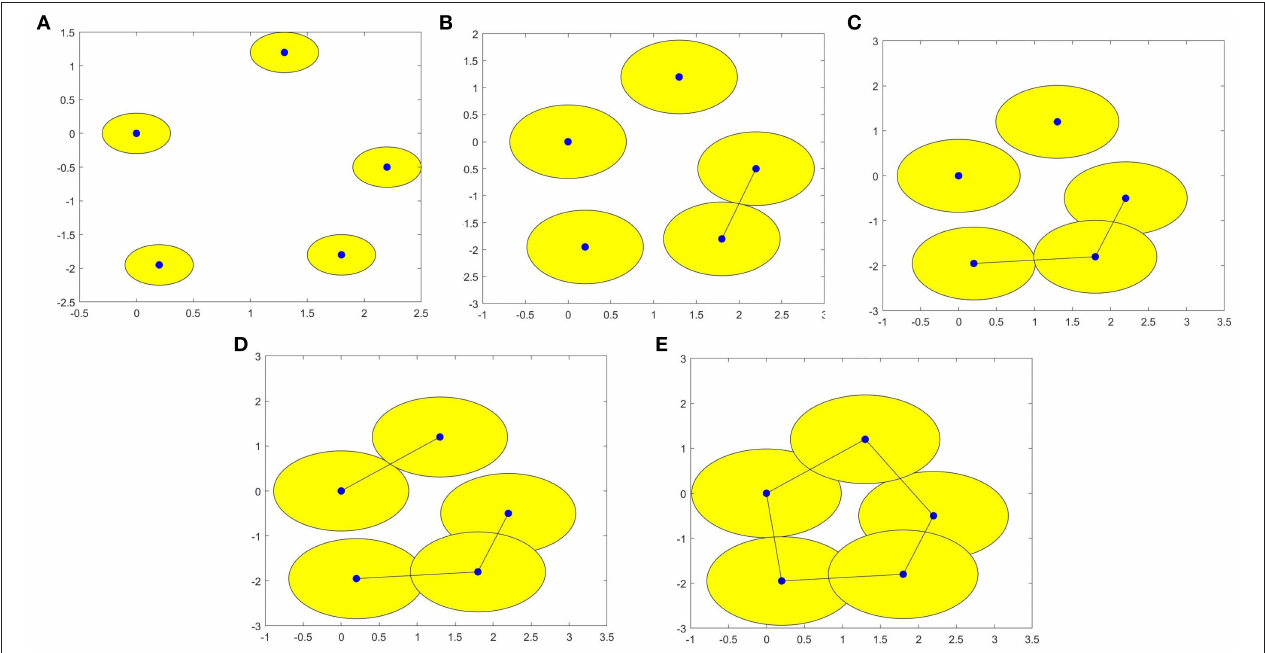
FIGURE 1 | (A–E) are VR (X, ε ) complexes of the point cloud data with ε = 0.60, 1.37, 1.62, 1.78, and 1.97